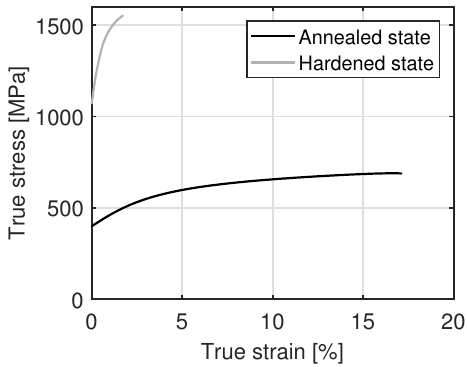
Figure 4. Flow curves of annealed and hardened 34MnB5 steel.